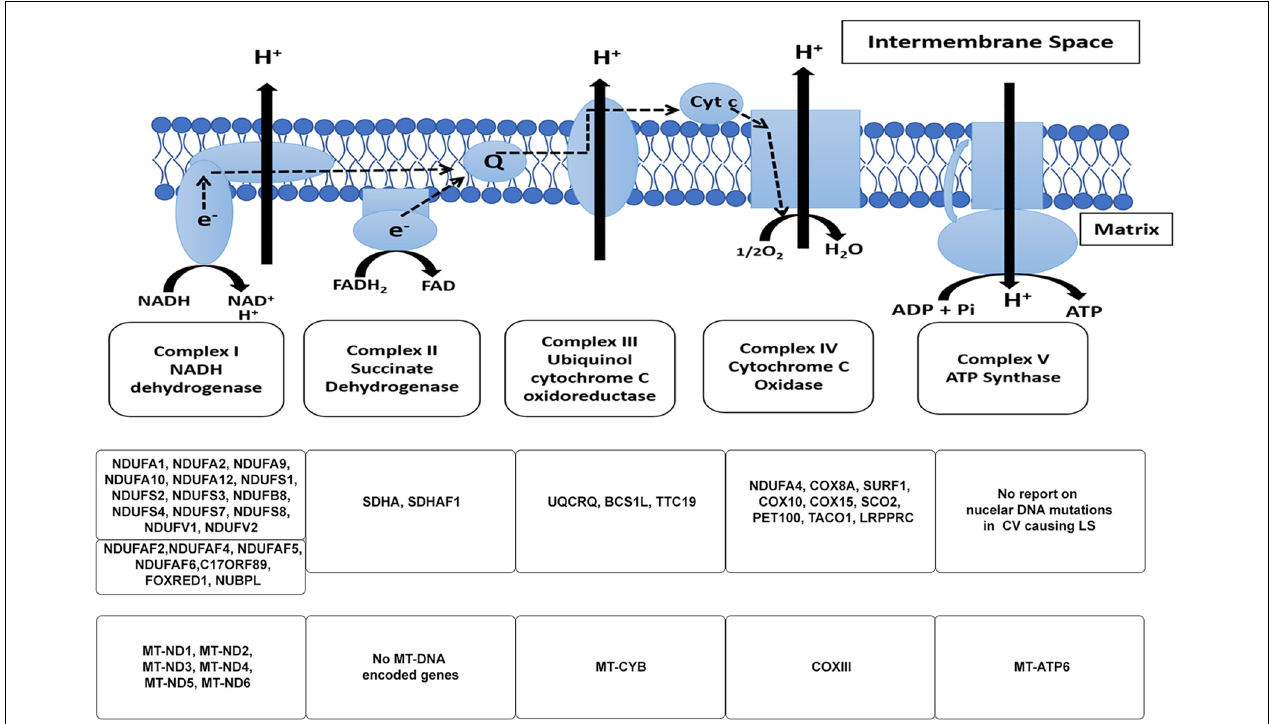
FIGURE 1 | The mitochondrial electron transport chain. The subunits of the respiratory chain are encoded by nDNA and mtDNA. Mitochondria produce ATP via the OXPHOS pathway; a process that takes place at the inner mitochondrial membrane involves the channeling of electrons through four-electron transport chain (ETC) complexes (Complex I–IV). The electron transport results in subsequent translocation of protons from the matrix into the intermembrane space, this proton gradient in combination with the inward-negative mitochondrial membrane potential drives the molecular motor, ATP synthase (complex V), to produce ATP. An impairment in the ETC or its assembly complexes results in metabolic malfunction in cells and tissues. The ETC is a vast complex comprising ∼ 90 different subunits which make up the five enzyme complexes of OXPHOS. Of these subunits, mtDNA encodes 13 subunits while the nuclear DNA (nDNA) encodes ∼ 77 subunits. Together, the nDNA and mtDNA coordinate the synthesis of subunits that come together to form the individual complexes that compose the ETC, subsequently allowing the mitochondria to function as the core energy producer for cellular needs. Specific genes encoded by nDNA and mtDNA in the context of LS are